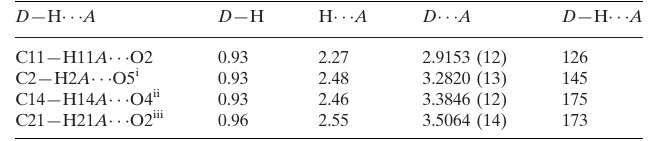
Hydrogen-bond geometry (A˚ , (cid:3)